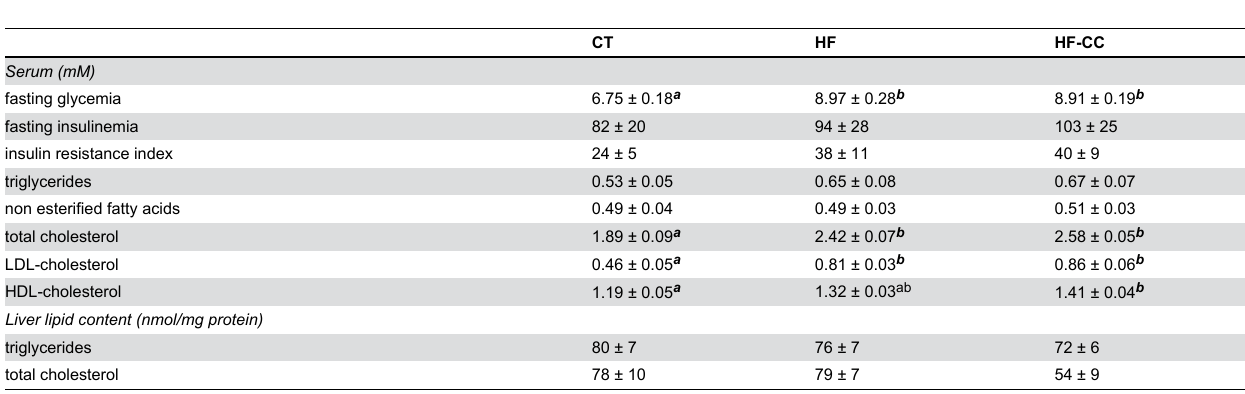
Table 2. Blood and hepatic